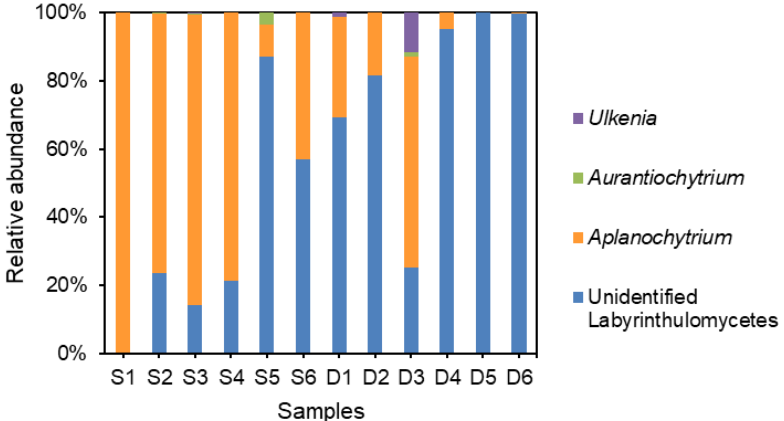
Figure 4. Composition of Labyrinthulomycetes communities (at the genus level) across samples inshore and offshore habitats. S1–S3: inshore surface; S4–S6: offshore surface; D1–D3: inshore deep; from inshore and offshore habitats. S1 – S3: inshore surface; S4 – S6: offshore surface; D1 – D3: inshore and D4–D6: offshore deep; and D4 – D6: offshore deep.